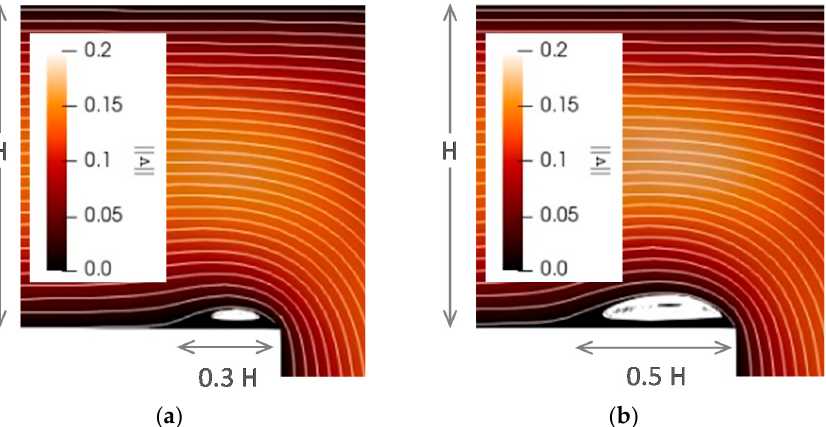
Figure 11. Upstream elastic vortices, effect of Weissenberg number (Polymer flow Re = 1 × 10 − 6 ): ( a ) Wi = 1, El = 1 × 10 6 ; ( b ) Wi = 1.5, El = 1.5 × 10 6 .